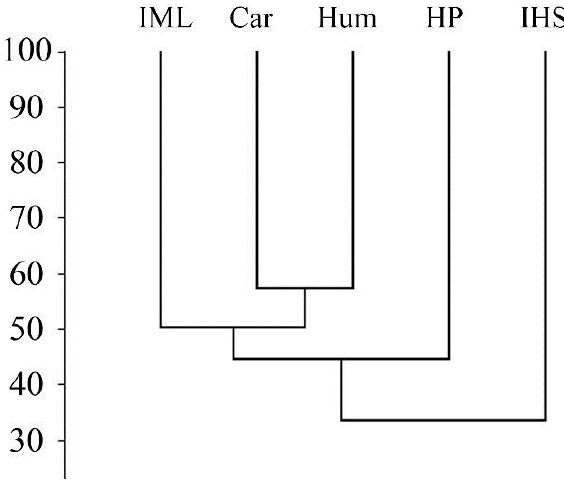
Figure 8. Dendrogram showing the Bray-Curtis similarity (%) of biotope types by species diversity of centrohelids. Abbreviations: IML = in-mire lake; Car = carpets; Hum = hummocks; HP = hollow-pools; IHS = inter-hummock